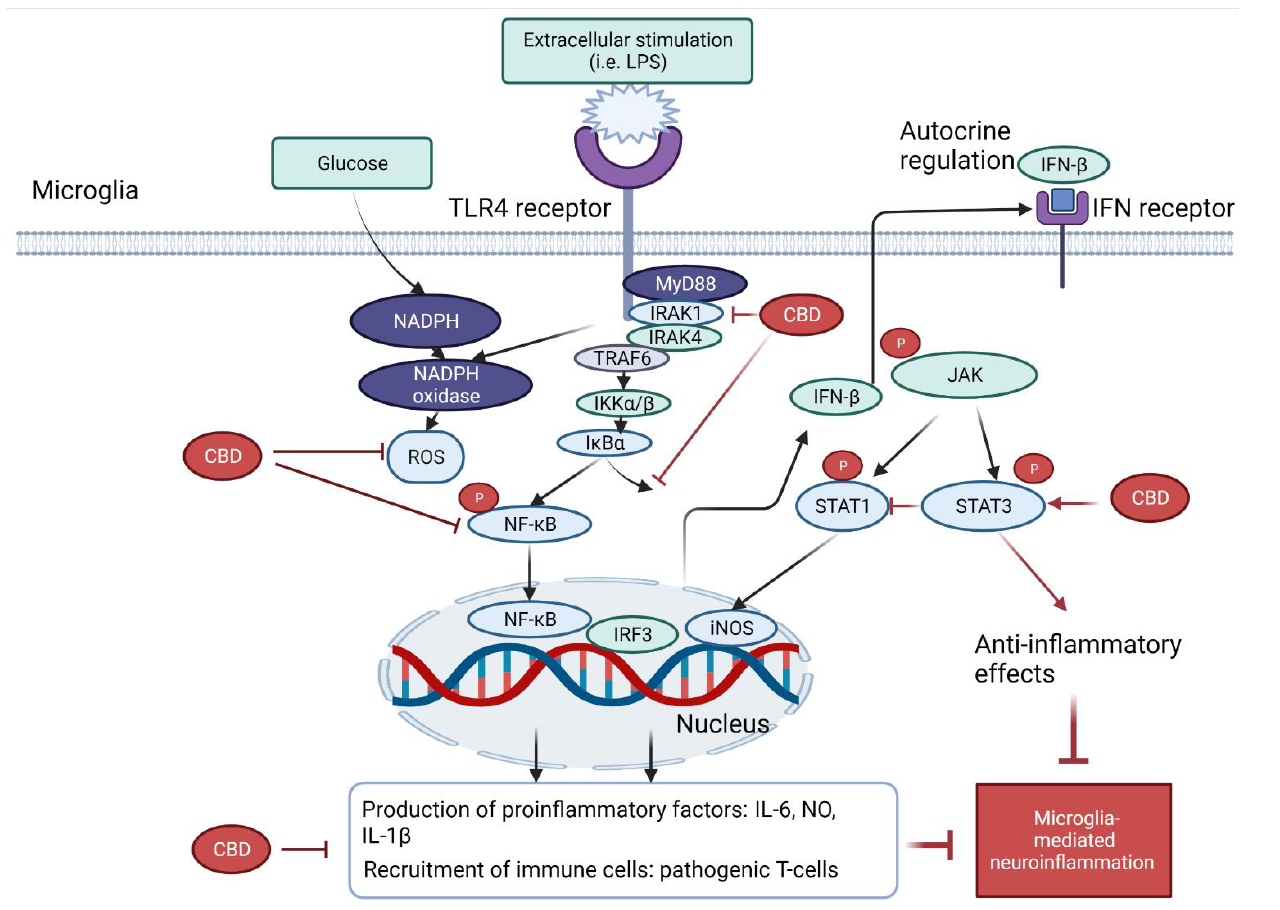
Figure 2. Schematic diagram of anti-neuroinflammatory effects of CBD related to NF- κ B and STAT- 3 pathways. The activation of TLR4 of microglia stimulates the production of ROS by NADPH oxi-